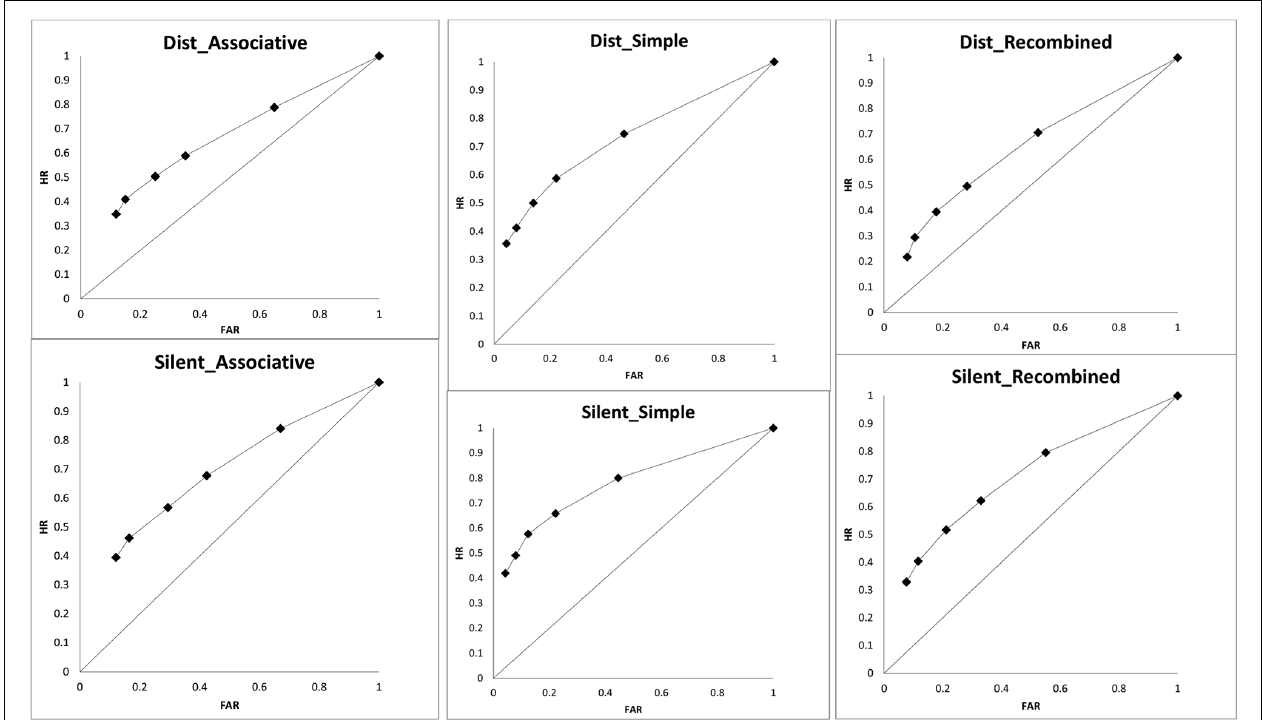
FIGURE 3 | Hit rates (HR) plotted against false alarm rates (FAR) for distraction (Dist) and silent control conditions on the associative, simple, and recombined testing conditions.